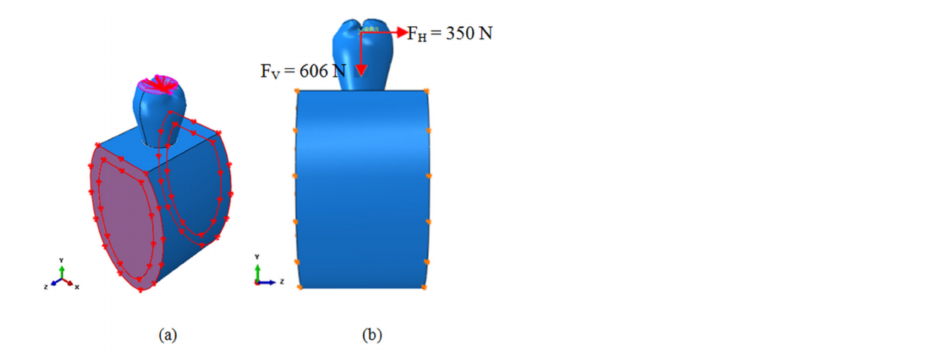
Figure 2. ( a ) Assumed loading and boundary conditions for the model, ( b ) the directions of the loads.